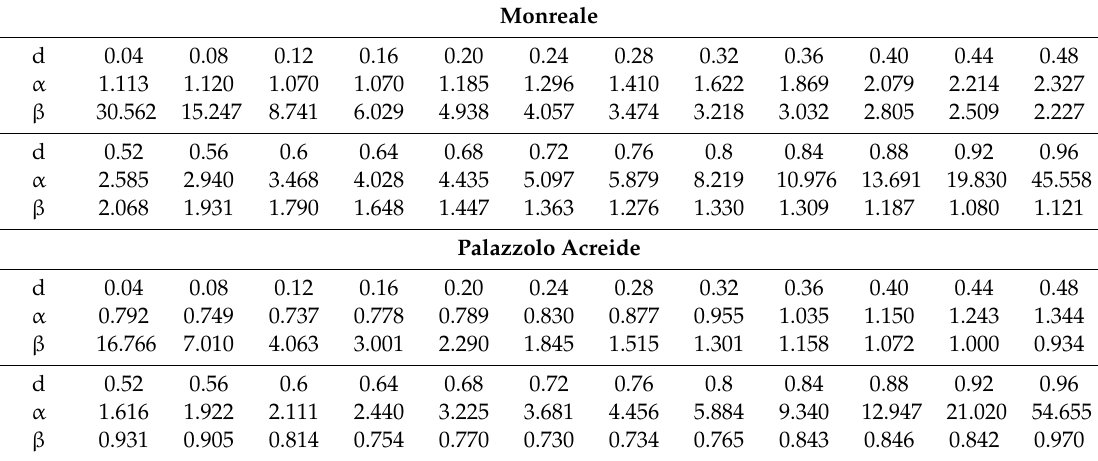
Table 5. Beta distribution parameters for di ff erent normalized time-step.